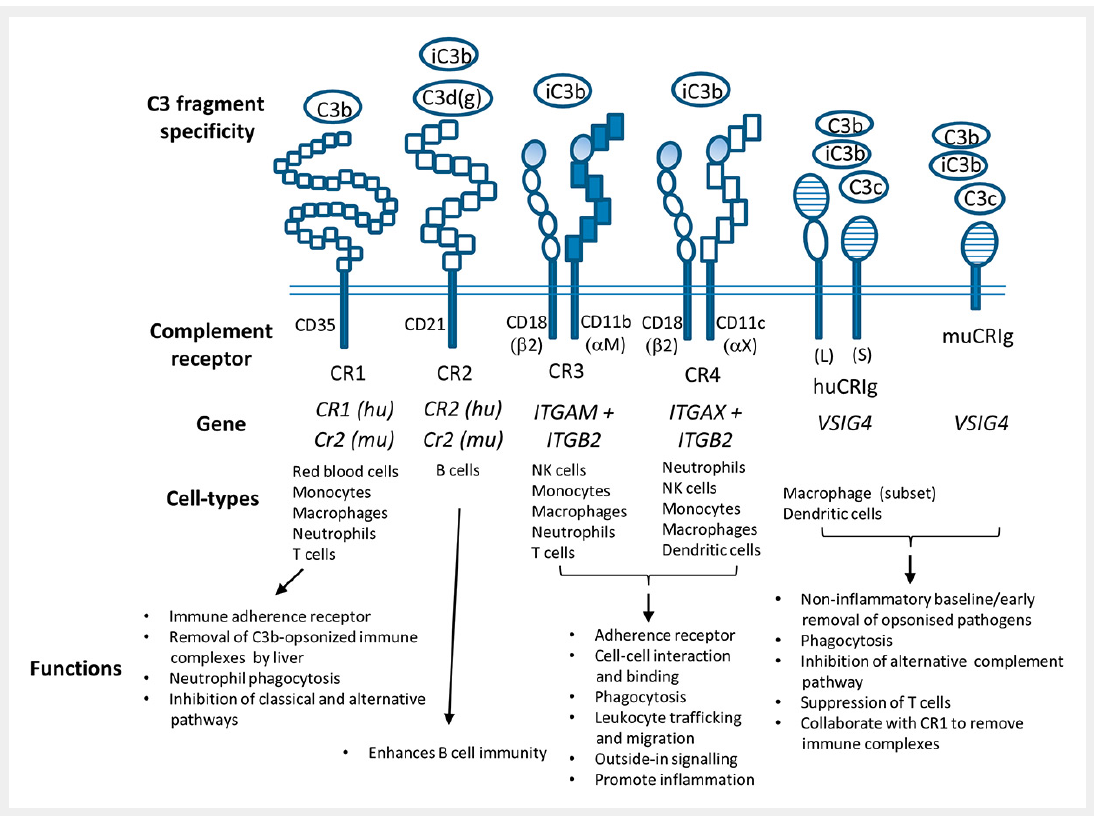
Figure 2 Characteristics, function and expression of complement receptors The structural domains of the five known types of complement receptors are depicted, together with their specificity of C3 fragments, the genes encoding them, their distribution amongst the different leucocyte types and their known functions. CR1, CR2 and CRIg are single transmembrane proteins with extracellular portions, transmembrane domains and cytoplasmic tails whereas CR3 and CR4 are transmembrane heterodimers of a common β2 integrin (CD18) chain and an α integrin chain, αM (CD11b) or αX (CD11c). Murine CR1 and CR2 are derived from the same gene by alternative splicing whereas the human counterparts are encoded by 2 different genes. CR1 contains thirty short consensus repeats (SCR) and CR2 has fifteen SCR. CD18 contains four repeats and a Von Willebrand factor type A domain (lightly shaded oblong shape). The α integrins contain, within their extracellular portions, seven FG-GAP repeats (rectangles) and a Von Willebrand factor type A domain. Two human CRIg isoforms, huCRIg(L) for the long form and huCRIg(S) for short, have been described. Both isoforms contain an N-terminal ligand binding domain that belongs to the IgV-type of immunoglobulin domains (horizontal stripes). The long form of CRIg also contains a membrane proximal domain that is an IgC-type immunoglobulin domain. The function of this domain is unclear. The murine form, similar to CRIg(S), contains only the IgV-type of immunoglobulin domain but the cytoplasmic tail is shorter than that of huCRIg(S). The IgV domains are believed to be responsible for binding C3